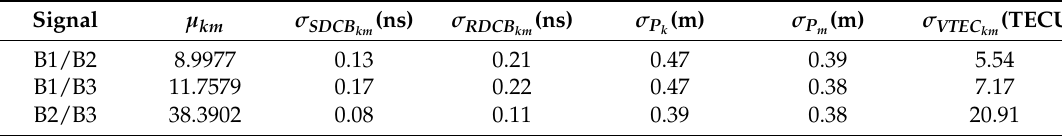
Table 3. Error of vertical total electron content (VTEC) derived from the code observation [19].